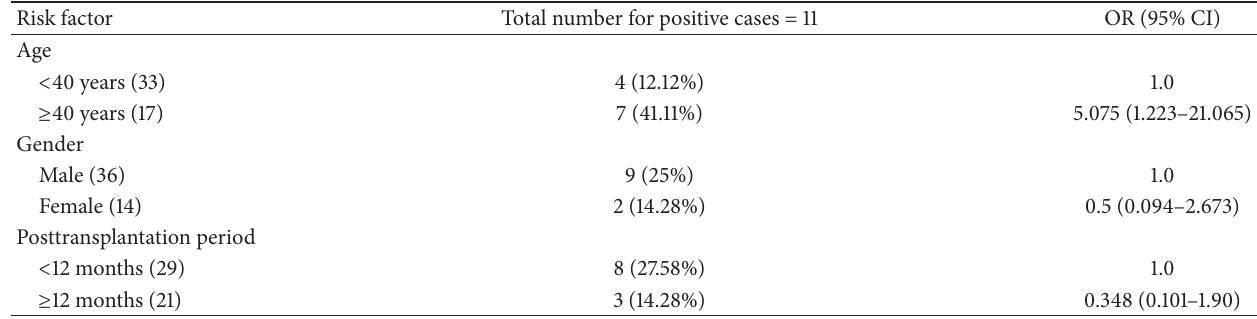
Table 2: Risk factor for infection with